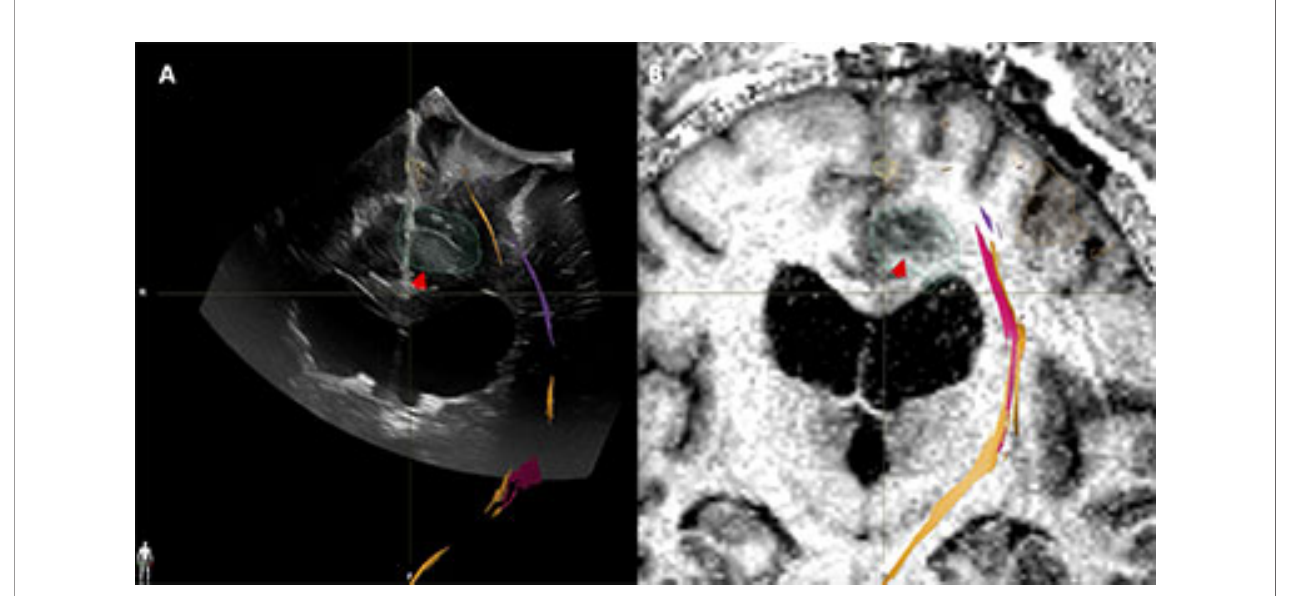
FIGURE 7 | Case3. iUS3 (A) showing unexpected residual tumor (red arrowhead) under the arachnoid fold which was con fi rmed by iMRI (B)